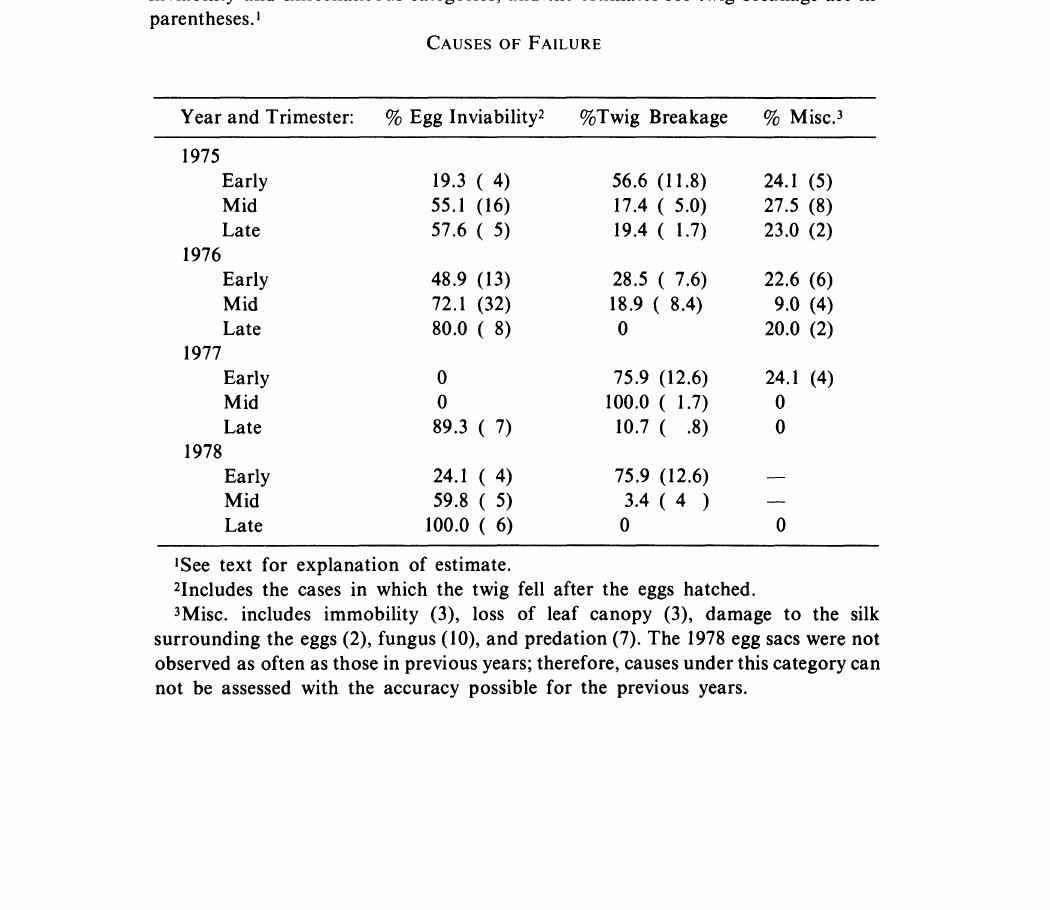
Table 2. Causes of spiderling failure to emerge from the egg sac according to the trimester of the season in which the egg sac was formed. Actual numbers for the egg inviability and miscellaneous categories, and the estimates for twig breakage are in